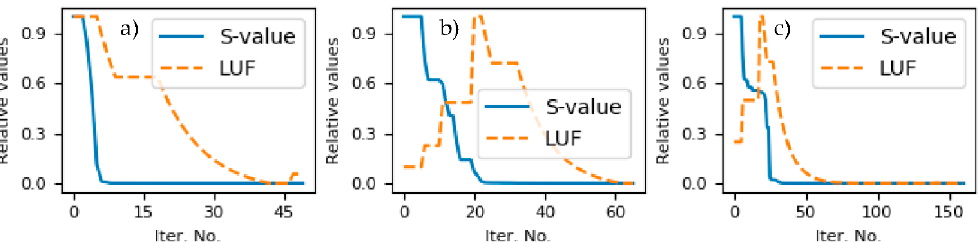
Figure 5. S -value and limits update factor (LUF) data obtained while using the automatic update limit strategy in ( a ) Figure 2, ( b ) Figure 3, and ( c ) Figure 4. EEC R(QR)(QR)(QR) (Figure 1) was used in the fitting attempts.